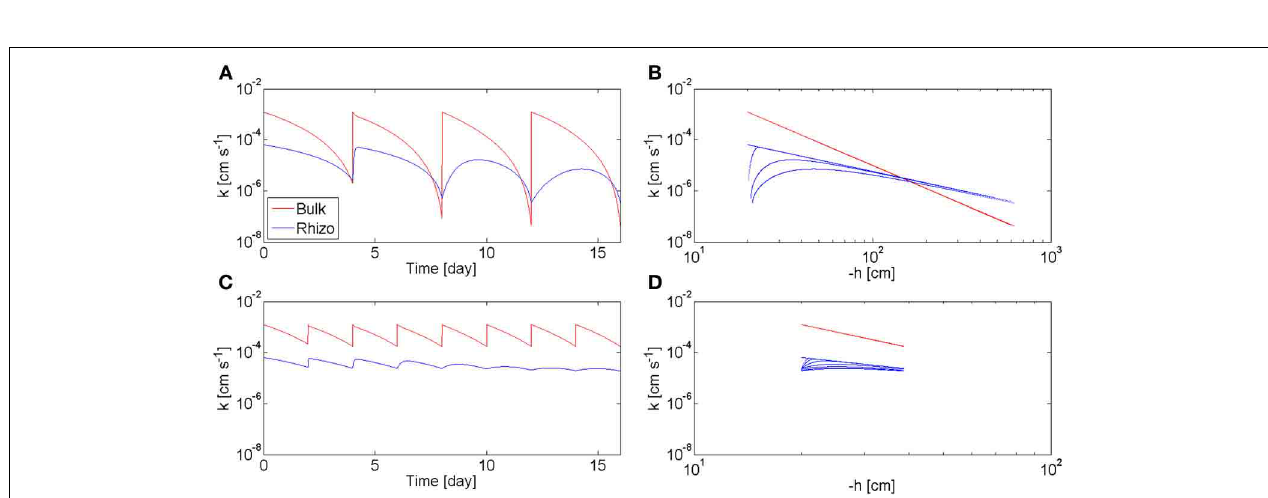
in rhizosphere and bulk soil during drying periods of 4 days and subsequent rewetting to a matric potential of h = − 20cm. During the first days, mucilage is fresh and rhizosphere is quickly rewetted. As mucilage ages, rhizosphere rewetting becomes slower. (C) Simulation with drying periods of 2 days.